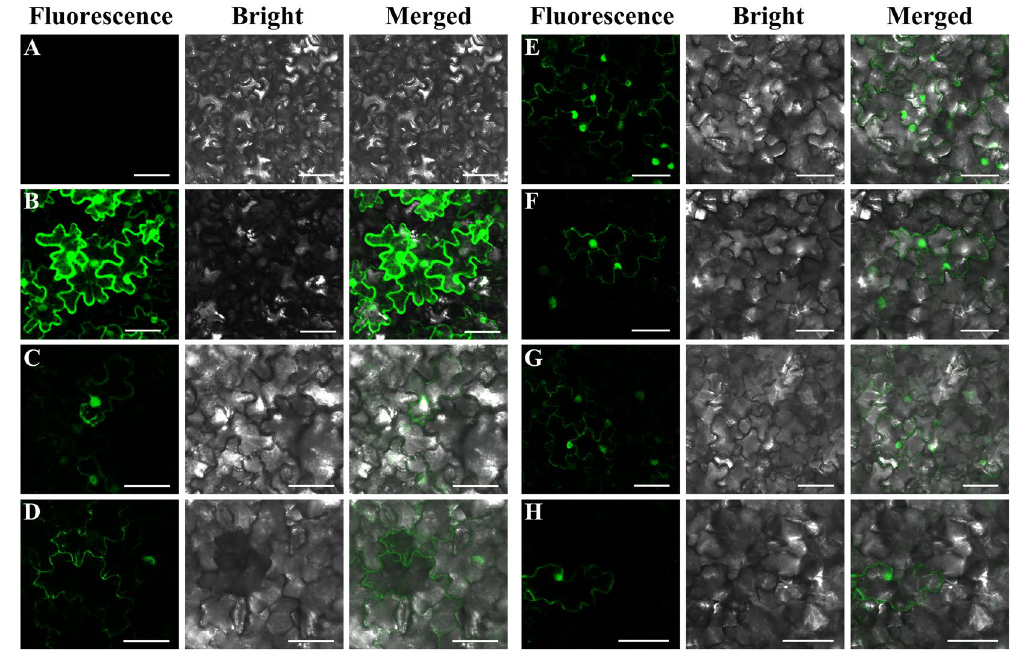
Figure 7. The sub-cellular localization of six GFP-BnPP2 proteins by transient expression in tobacco leaves. ( A ) Indicated tobacco cells that were not transiently transformed. ( B ) Indicated transiently transformed tobacco cells carrying pEGAD. ( C–H ) indicated GFP-BnPP2-1, GFP-BnPP2-6, GFP-BnPP2-7, GFP-BnPP2-9, GFP- BnPP2-11 and GFP-BnPP2-12, respectively. Bar = 50 µ